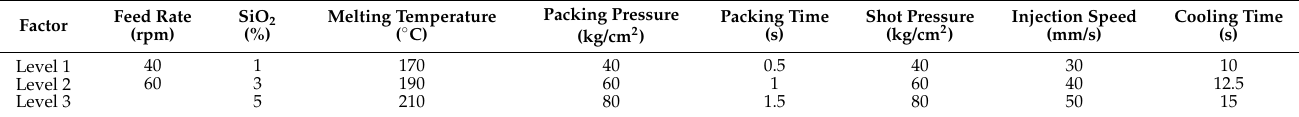
Table 2. Experimental parameters of orthogonal